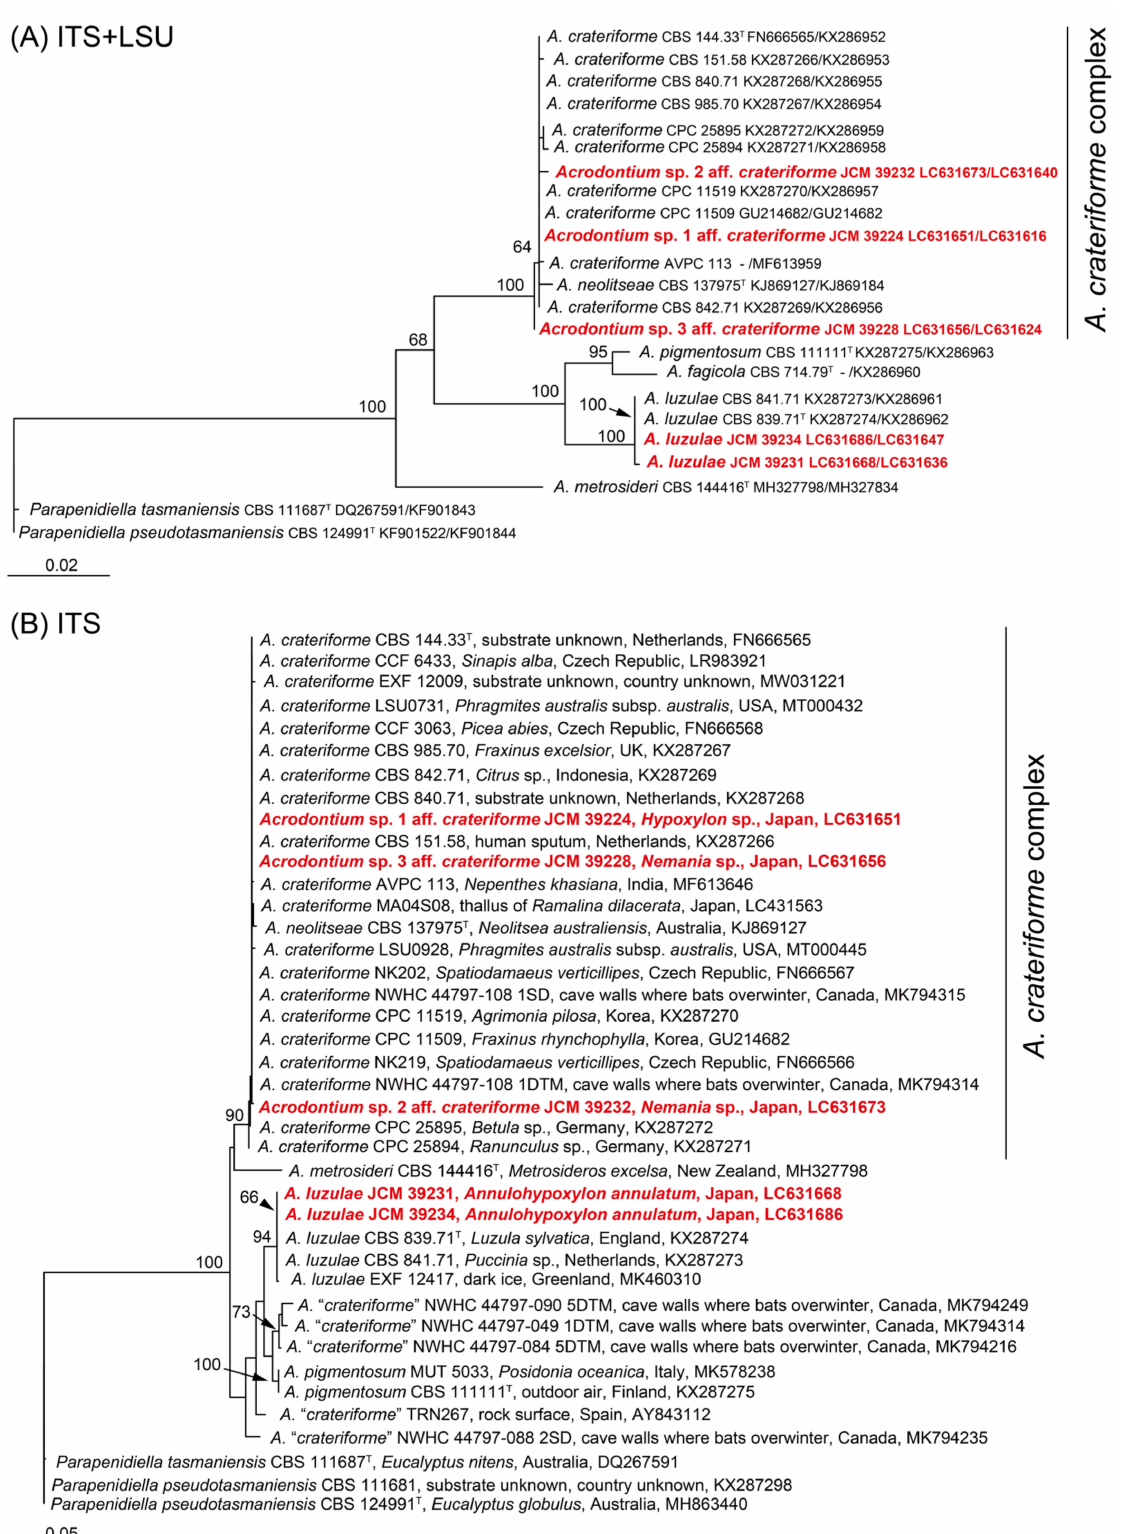
Figure 5. Maximum-likelihood (ML) tree of Acrodontium species. ( A ) Species relationship of Acrodontium by GTR+F model based on the ITS and LSU sequences. ( B ) Comparison of environmental samples with Acrodontium species by TIMe+R2 model based on the ITS sequences. Standard nonparametric bootstrap greater than or equal to 60% are presented at the nodes. Ex-type strains are indicated with a superscript T. The newly obtained sequences are shown in bold. The scale bar represents nucleotide substitution per